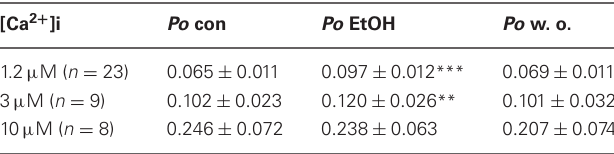
Table 2 | Effect of 30mM EtOH on BK channel open probability ( Po ) compared to control conditions (con) at different levels of [Ca 2 +